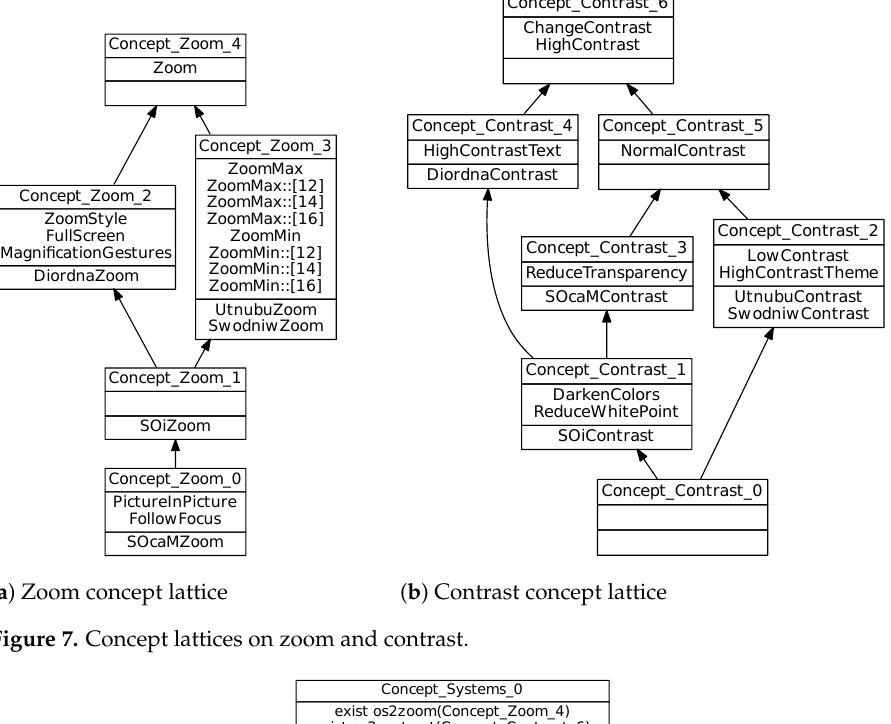
Figure 7. Concept lattices on zoom and contrast.